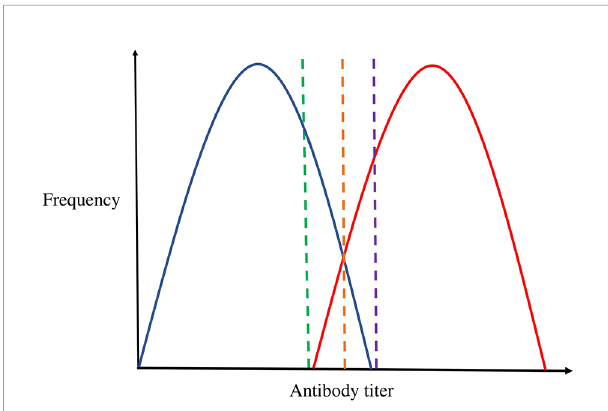
FIGURE 1 | The challenge of thresholding continuous antibody measures. Blue represents the distribution of uninfected individuals; Red represents the distribution of infected individuals. The green, orange, and purple dashed lines represent cut-off points. This fi gure depicts the theoretical overlap in antibody distribution of uninfected individuals (represented in blue) and infected individuals (represented in red), and the coloured dashed lines denotes how cut-offs may be selected. For example, the green threshold would include all infected individuals as cases, but also include a proportion of uninfected individuals as cases. Alternatively, the purple threshold would result in no uninfected individuals included as cases, but miss some that are infected. The orange threshold may be ideal as it would minimise the proportion of individuals misclassi fi ed as either cases or controls. However, the true underlying two distributions are not separately observed and so can only ever be estimated from the overall